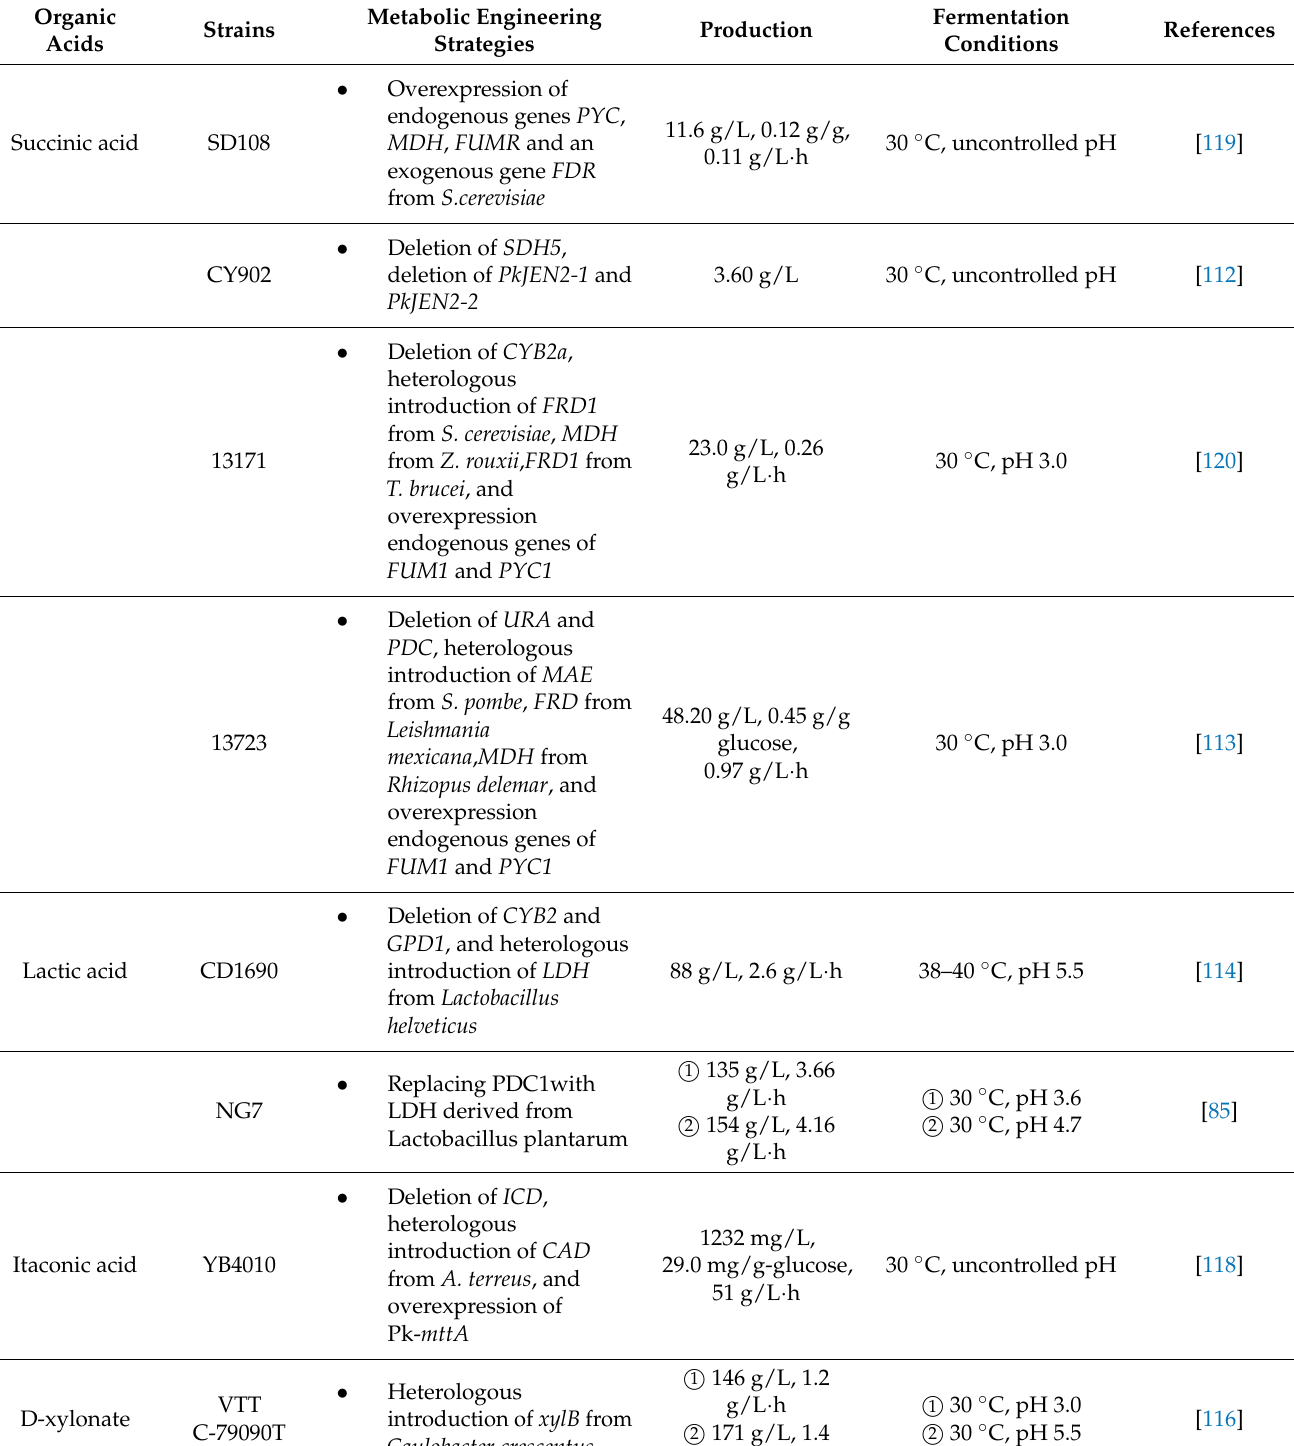
Table 3. Summary of organic acids production by engineered P. kudriavzevii